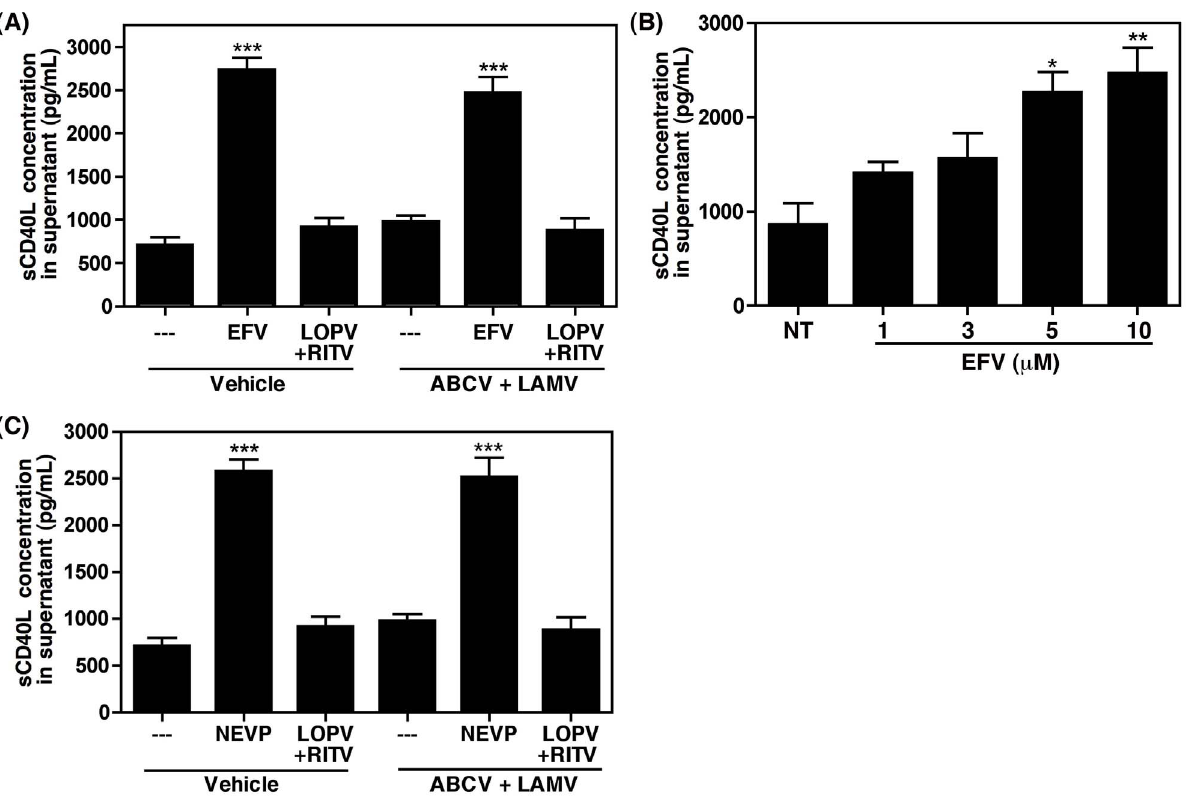
Figure 2. Non-nucleoside reverse transcriptase inhibitors (NNRTIs) induce sCD40L release from washed human platelets. (A) Platelets isolated from healthy donors were treated as indicated and analyzed via ELISA specific for sCD40L. Efavirenz (EFV), but not the protease inhibitors lopinavir and ritonavir (LOPV + RITV), induce sCD40L release, indicating that EFV directly activates platelets. (B) EFV induces sCD40L release in a dose dependent manner in washed human platelets, with significance achieved at physiologically relevant concentrations. (C) The NNRTI nevirapine (NEVP) also induces the release of sCD40L directly from isolated human platelets. In panels A – C values were compared via one-way ANOVA followed by Bonferroni’s test for multiple comparisons, which indicated statistical significance as *p , 0.05, **p , 0.01, and ***p ,